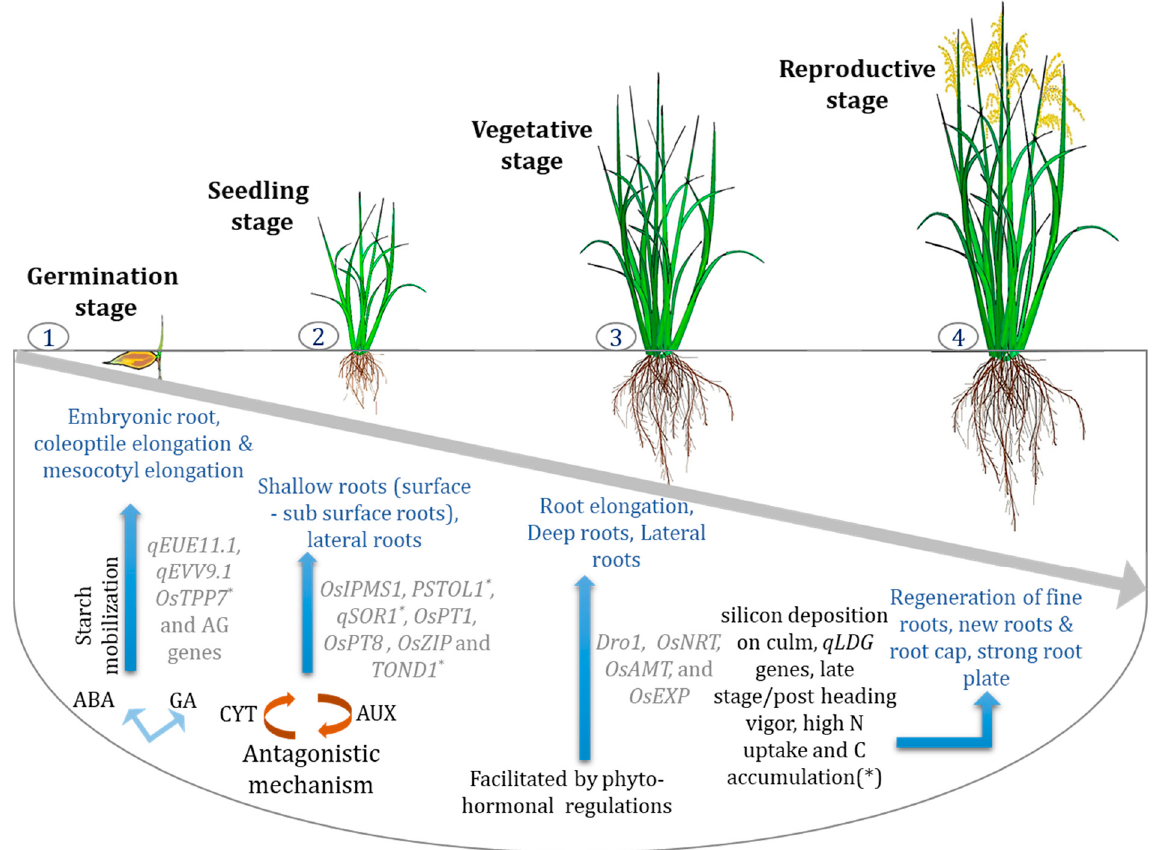
Figure 2. Ideal DSR root system with root-specific traits and genes/QTLs at different stages of growth. The varying growth stages have different requirements of root morphology and associated genes/QTLs depicted in the Figure. ( 1 ) The germi- nating seed requires AG genes for germination: qEUE11.1 and qEVV9.1 for early high seedling vigor and qSOR1 for better surface rooting. ( 2 ) From the nutrient perspective, the seedling stage would require OsPT1 and OsPT8 for P uptake, OsZIP genes for Zn uptake, and TOND1 for nitrogen deficiency tolerance, supplemented with PSTOL1 (a root growth enhancer). ( 3 ) The vegetative stage needs DRO genes that articulate the roots working in complementation with SOR, OsNRT , and OsAMT genes for nitrogen transport efficiency, expansin genes (such as OsEXP ) for growth of root hair and increased root length, and most of the roots are ideally at a 45° angle with each other measured from the base. ( 4 ) The reproductive stage needs better anchorage and root spread, higher silicon deposition on culm supplemented with qLDG genes for lodging tolerance, higher nutrient and moisture uptake compensated with more fine roots, new roots and root cap development, high N uptake, and C accumulation. * The genes/QTLs for these attributes are yet to be identified.